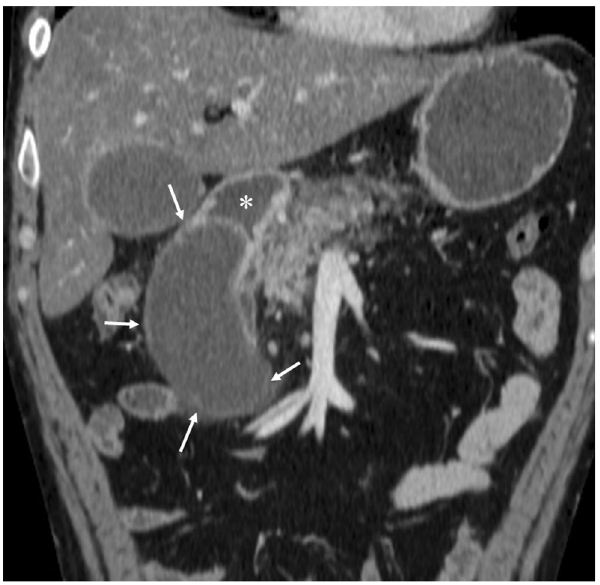
Fig. 1 Duodenal duplication cyst. Reformatted coronal contrast- enhanced CT image shows a large well-circumscribed cystic mass (arrows) adjacent to the second duodenal portion. There is no communication with the duodenal lumen